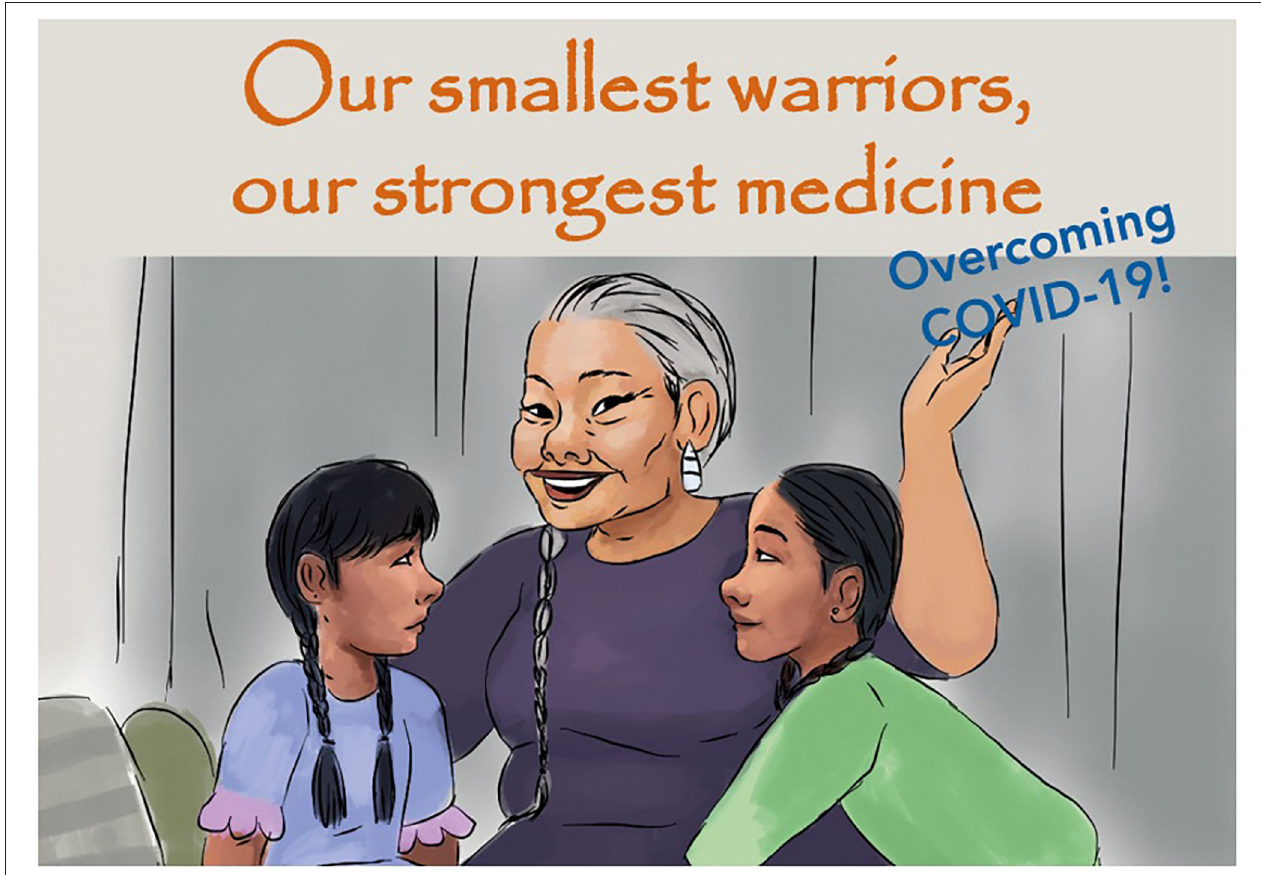
FIGURE 1 | Front cover of “Our Smallest Warriors, Our Strongest Medicine: Overcoming COVID-19.”